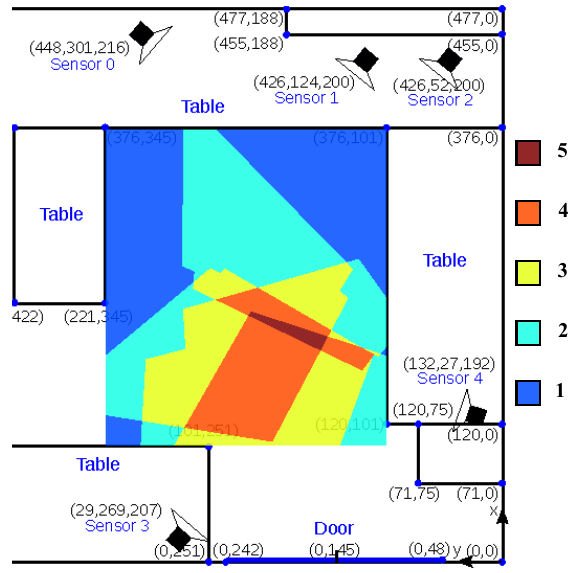
Figure 2. Room layout showing the configuration of five visual sensors (each containing stereo mouse sensor) covering an area of 5 × 5 m 2 . The colors indicate the number of cameras observing a specific point on the ground